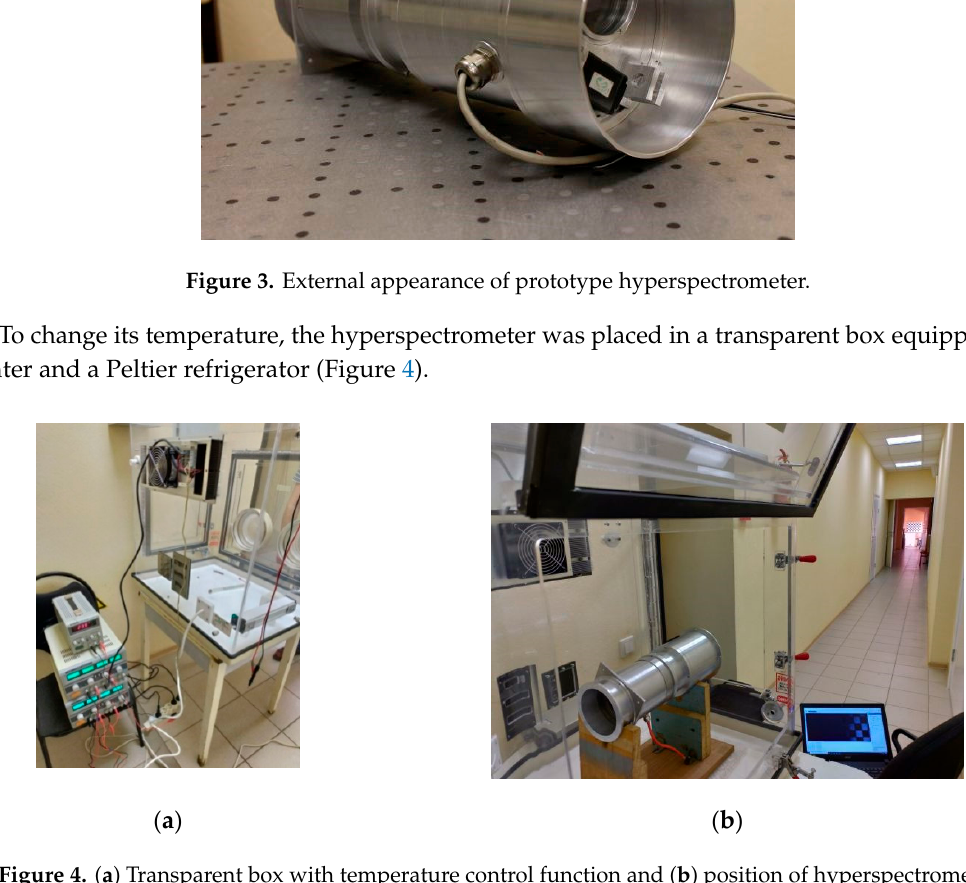
Figure 4. ( a ) Transparent box with temperature control function and ( b ) position of hyperspectrometer during the experiment.